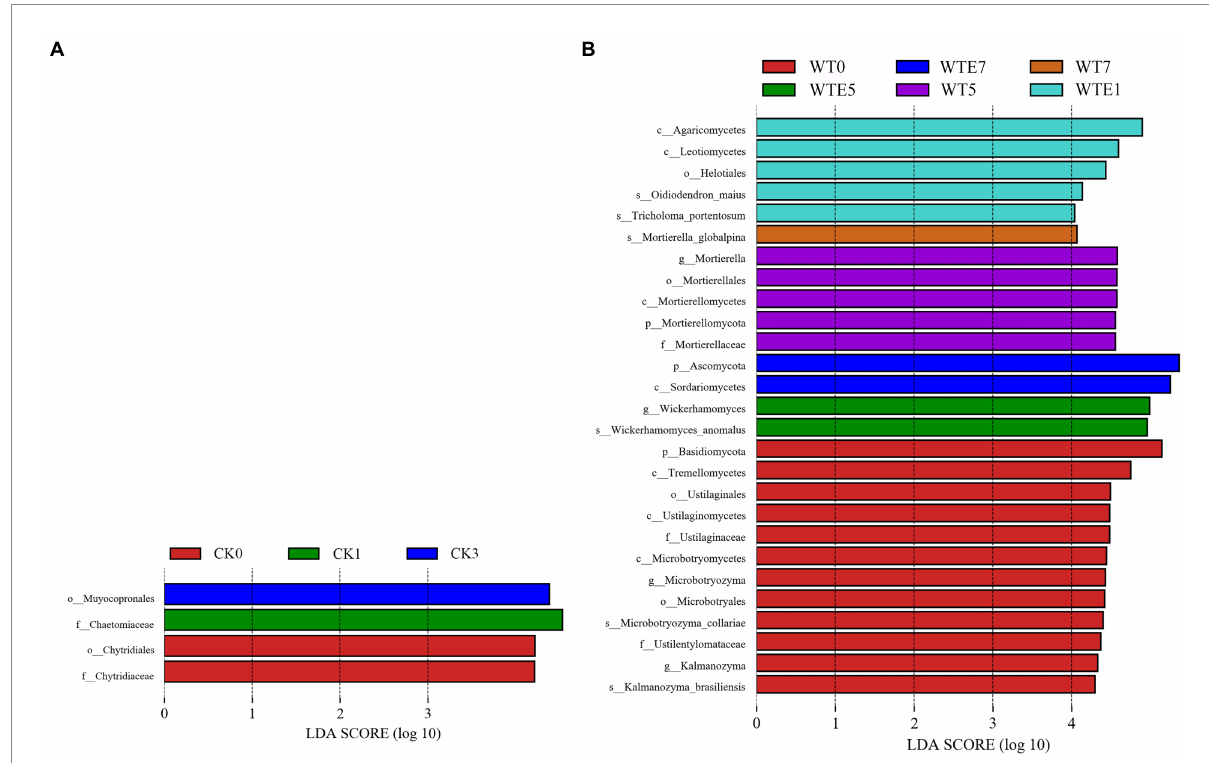
FIGURE 4 Comparison of fungal changes during ensiling and aerobic exposure using LEfSe analysis. ( A , CK group; B , WT group; CK, unwilted silage; CKE, unwilted silage aerobic exposure; WT, wilting silage; WTE, wilting silage aerobic exposure; Arabic numerals indicate the time of